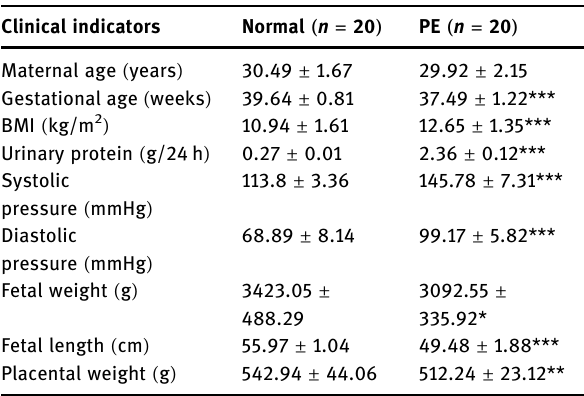
Table 1: Maternal and fetal baseline demographic data of the